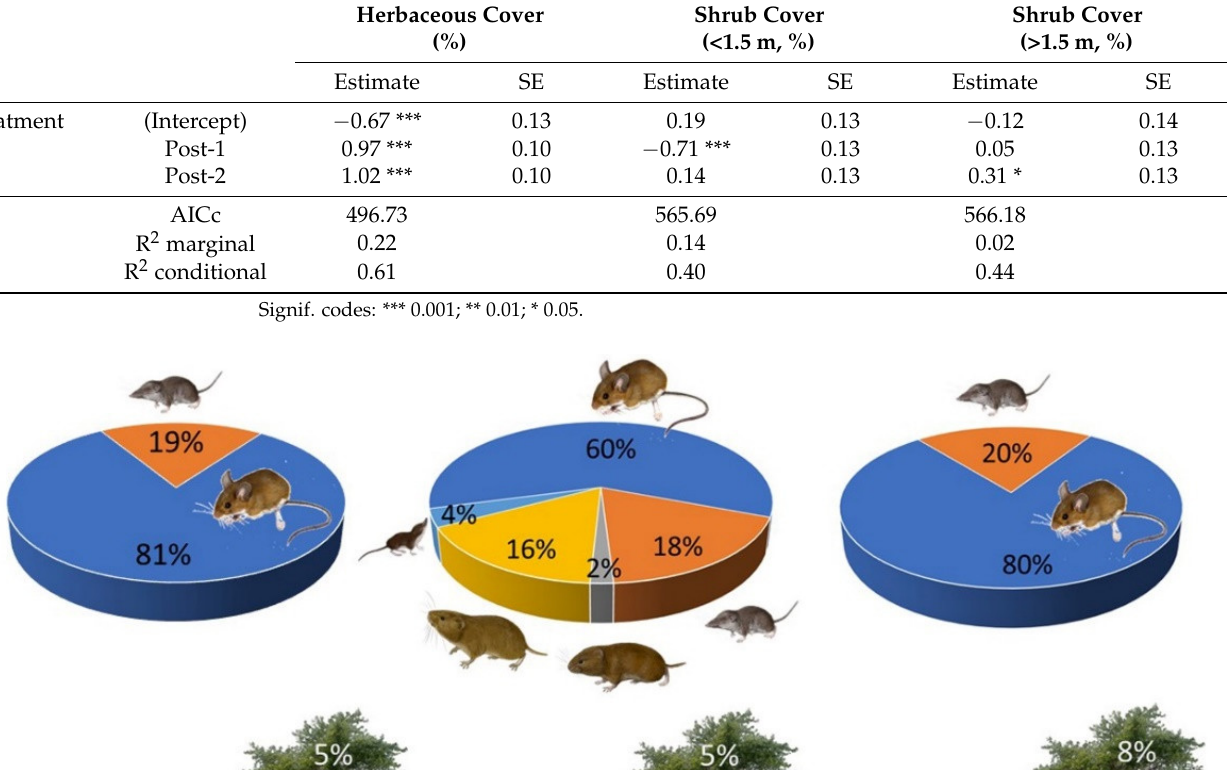
Table 1. Results of the GLMMs were performed with the three variables related to vegetation cover as a response, the treatment (three levels: Previous, Post-1, and Post-2) as a fixed factor, and the trap as a random factor. AICc values, and variance explained by fixed (marginal) and fixed + random (conditional) factors are also shown. Pre-treatment (previous) was the reference for statistical comparisons. Herbaceous Cover Shrub Cover (<1.5 m, %)